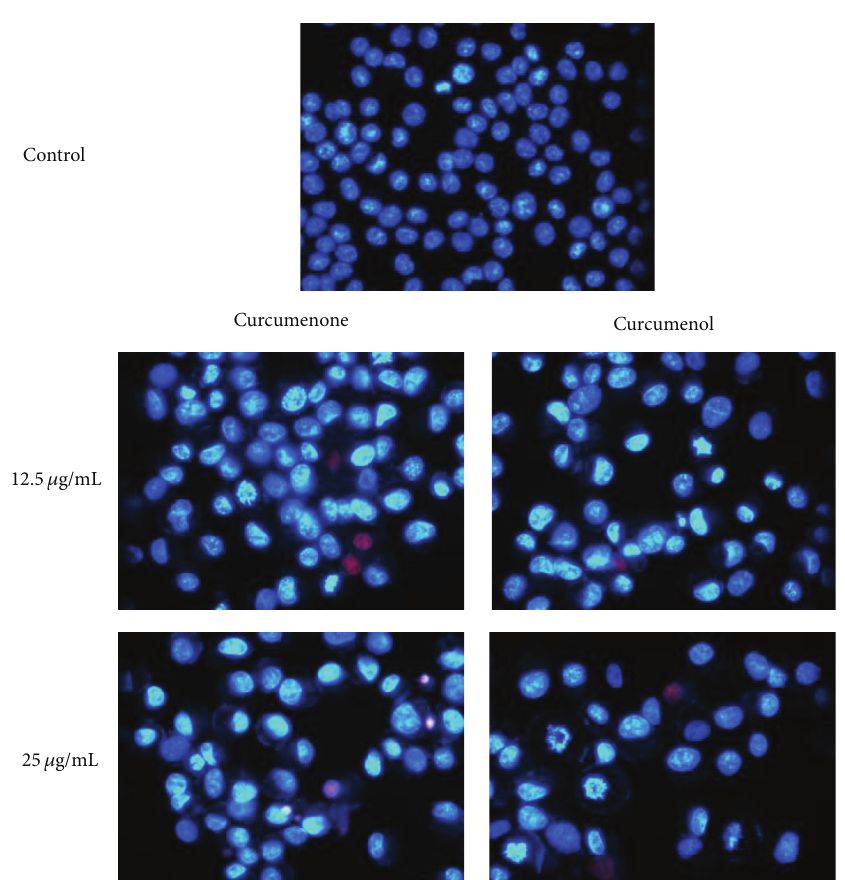
Figure 4: Apoptosis-inducing effect of curcumenone and curcumenol on MCF-7 cells by double staining using Hoechst 33342/PI and visualized under fluorescence microscope